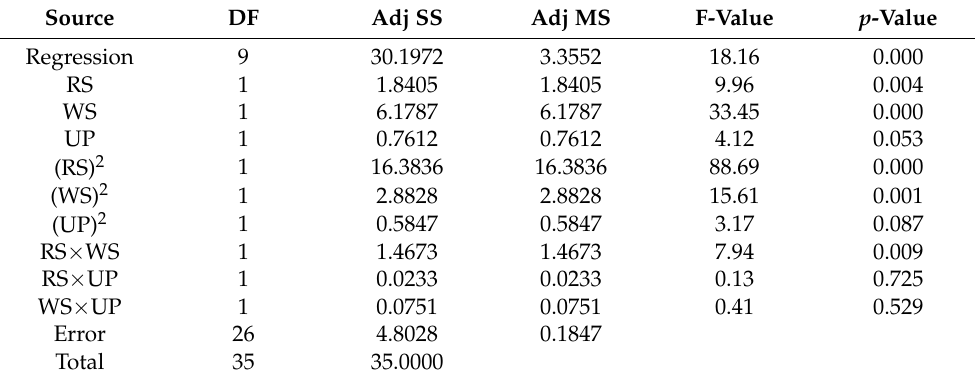
Table 5. ANOVA for UTS.